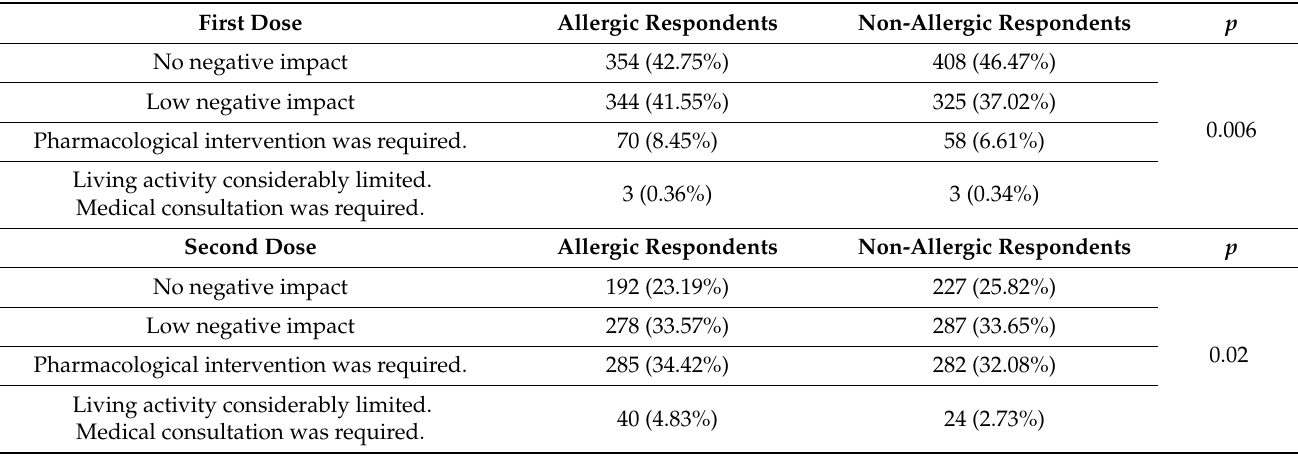
Table 3. Impact of adverse symptoms on the living activity of individuals receiving Pfizer-BioNTech anti COVID-19